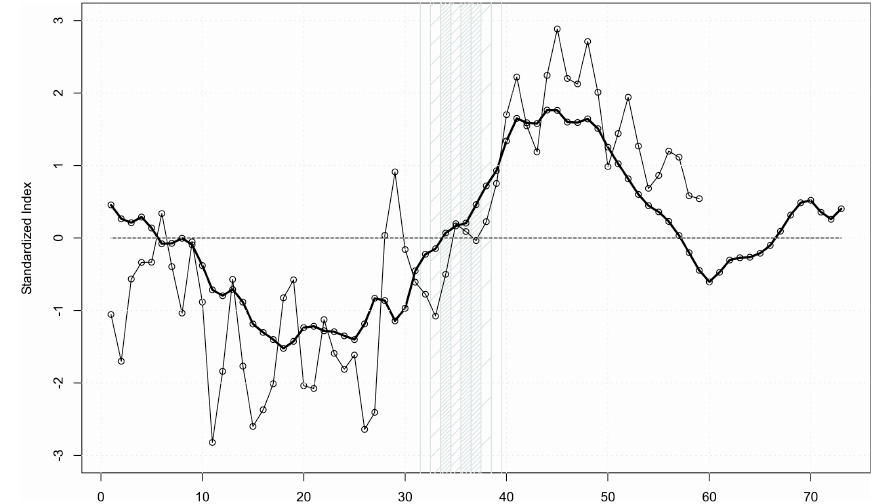
Figure 7. Time series of the 5-day monsoon index (see text for more details). The black (grey) line represents the averaged index over the period 1979–2000 (the 2006 index). Vertical bars represent the probability function defined in Sultan and Janicot (2003). The x-axis labels are expressed in pentads.